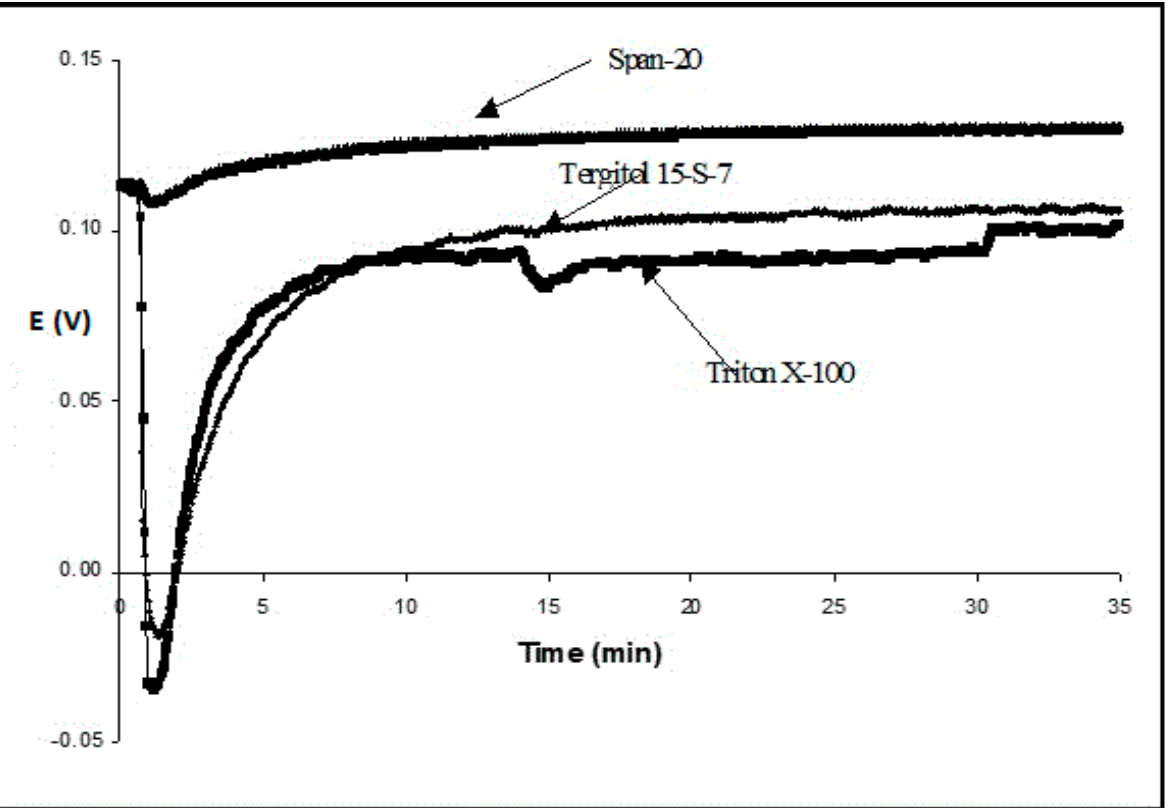
Figure 2. Transmembrane potential vs. time after the addition of 0.1 w/v % of different surfactants to the measuring (K + acceptor) chamber containing 5 mM buffer. The reference (K + donor) chamber contains 5 mM buffer + 0.5 M KCl.